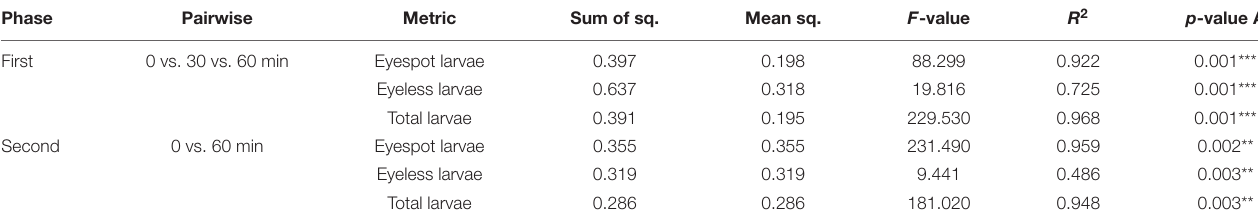
TABLE 5 | PERMANOVA analysis for the distribution difference in eyespot larvae, eyeless larvae, and total larvae of the hybrid oyster with time. Phase Pairwise Metric Sum of sq. Mean sq. F -value R 2 Eyespot